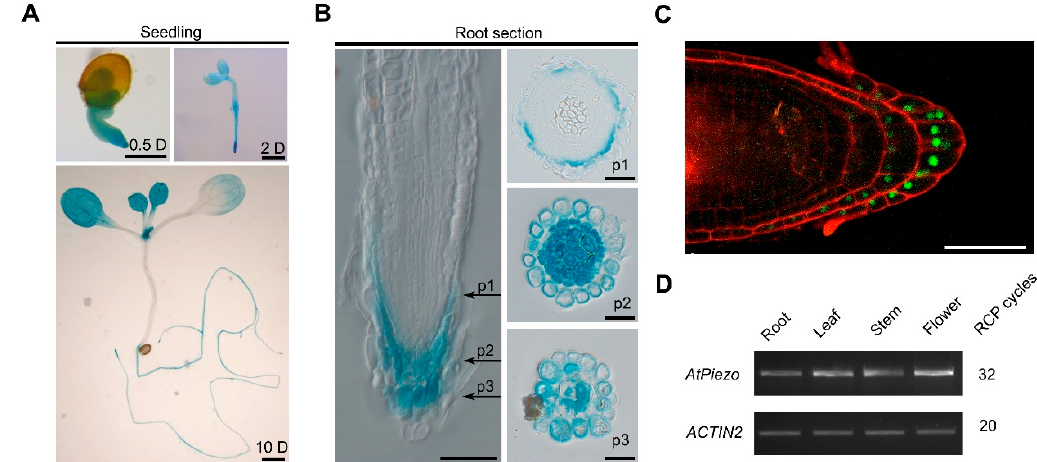
Figure 2. Expression patterns of AtPiezo in Arabidopsis . ( A ) Histochemical GUS staining is shown in 0.5-day-old, 2-day-old, and 10-day-old seedlings. Bars = 0.5 mm. ( B ) Longitudinal and cross sections of the root cap in different positions of pAtPiezo::GUS plant. Bars = 50 µ m and 20 µ m. ( C ) The expression of pAtPiezo::NLS-YFP in the root cap. Bars = 50 µ m. ( D ) RT-PCR analysis of AtPiezo transcripts in different tissues.